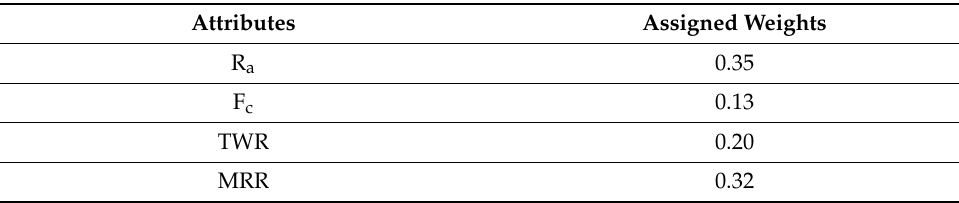
Table 5. Attributes and allocations of